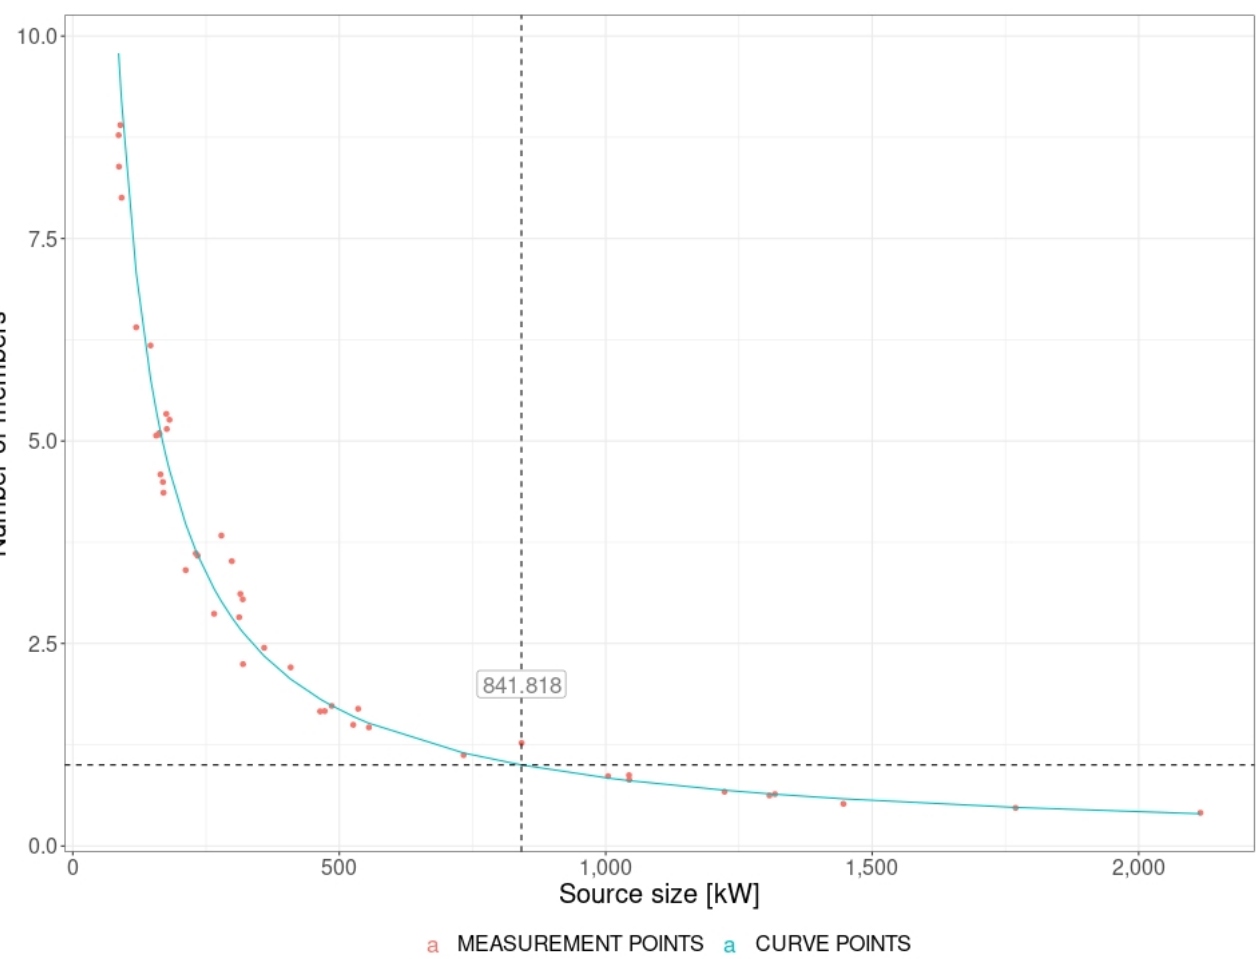
Figure 8. Empirical dependency of the number of cooperative members as a function of the capac- ity of generating sources.